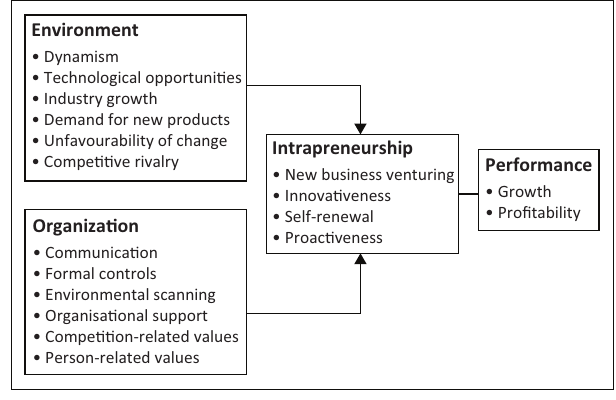
FIGURE 1: The intrapreneurship model and its direct